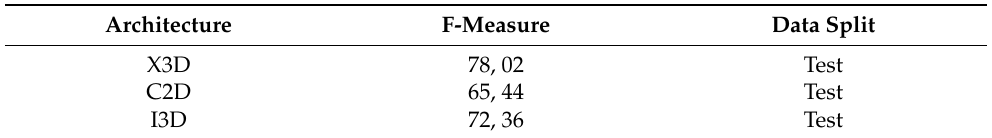
Table 1. Results on the test set. This table presents the f-measure value for each model evaluated in the test set. The column architecture represent the model evaluated while the f-measure represents the results obtained.